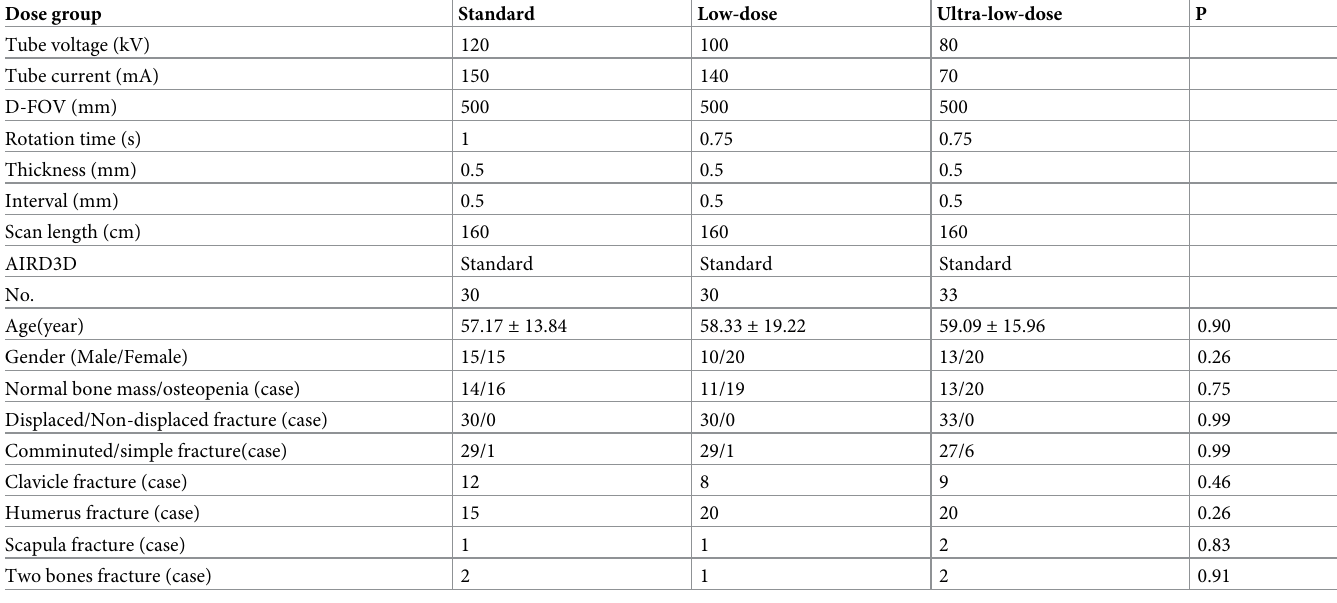
Table 1. CT parameters and patient information of each